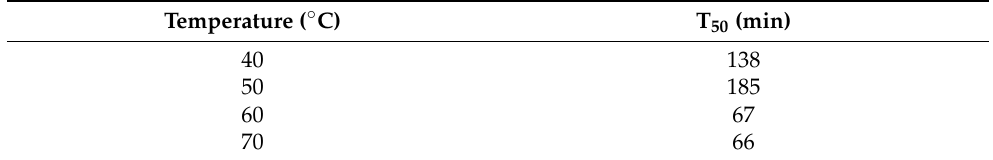
Table 4. T 50 of XEG of T. longibrachiatum